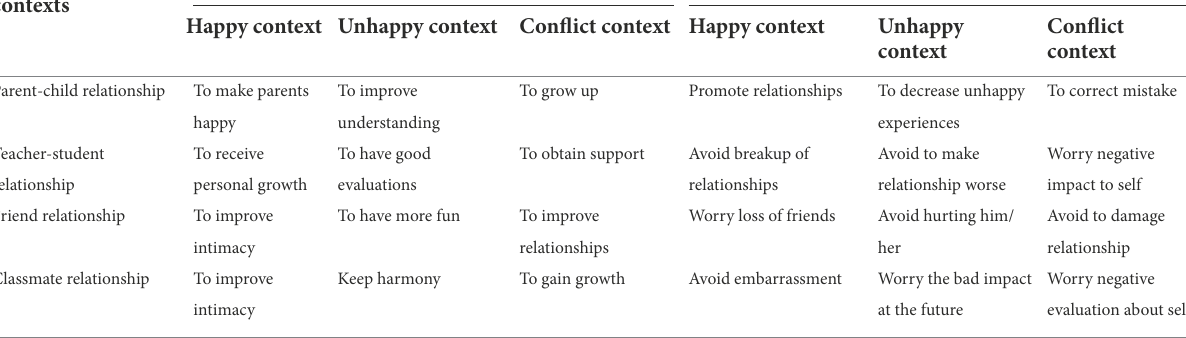
TABLE 2 Promotion-prevention focus in different relationship context from the